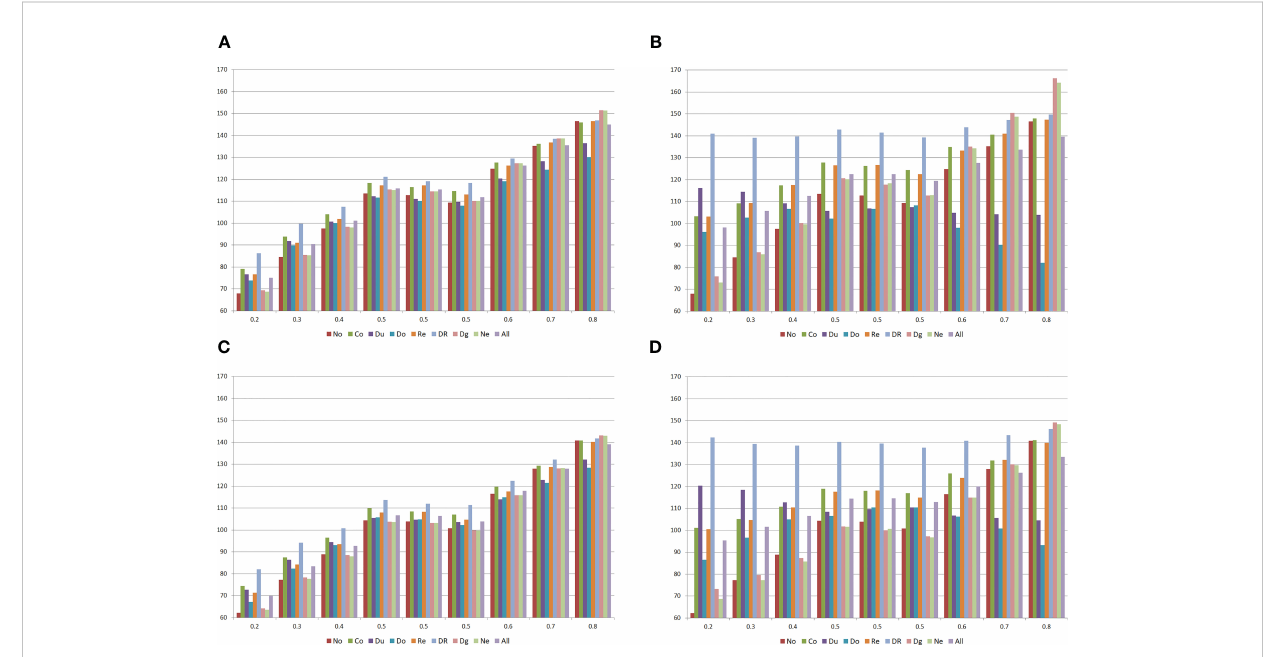
FIGURE 1 Means of the populations (A, B) and the selfed populations (C, D) for grain yield (g/plant), assuming no epistasis (No), seven types of digenic epistasis and an admixture of these types (All), 25% (A, C) and 100% (B, D) of epistatic genes, and ratio V(I)/(V(A) + V(D)) of 1. The populations are identi fi ed by the average allele frequency. Co = complementary, Du = duplicate, Do = dominant, Re = recessive, DR = dominant and recessive, Dg = duplicate genes with cumulative effects, and Ne = non-epistatic genic